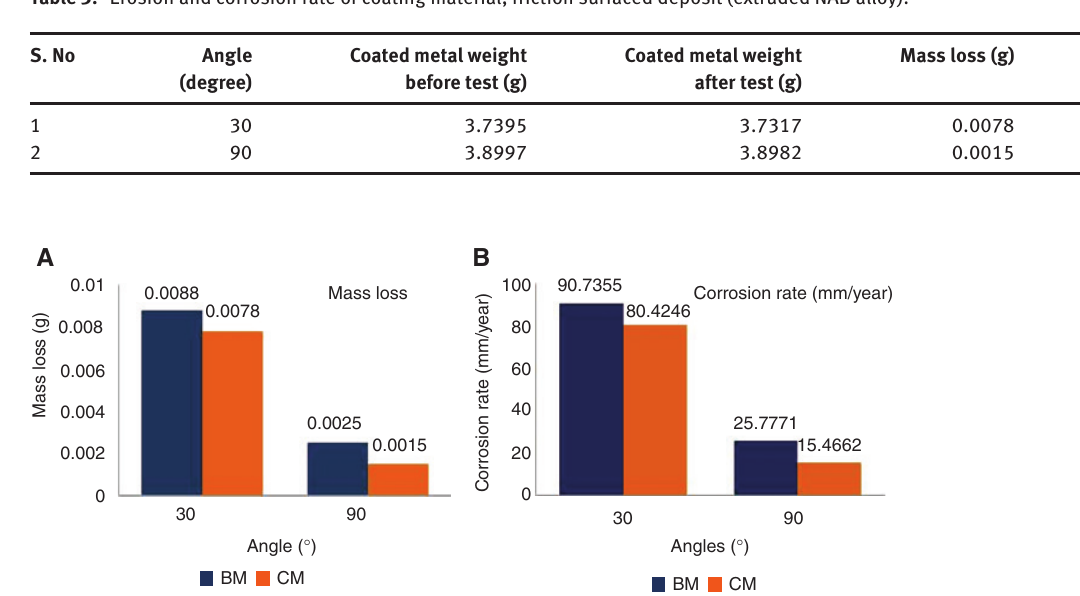
Figure 4: Bar chart shows the effect of impact angles in erosion rate (A) mass loss and (B) corrosion rate (CM-coated metal, BM-base metal).